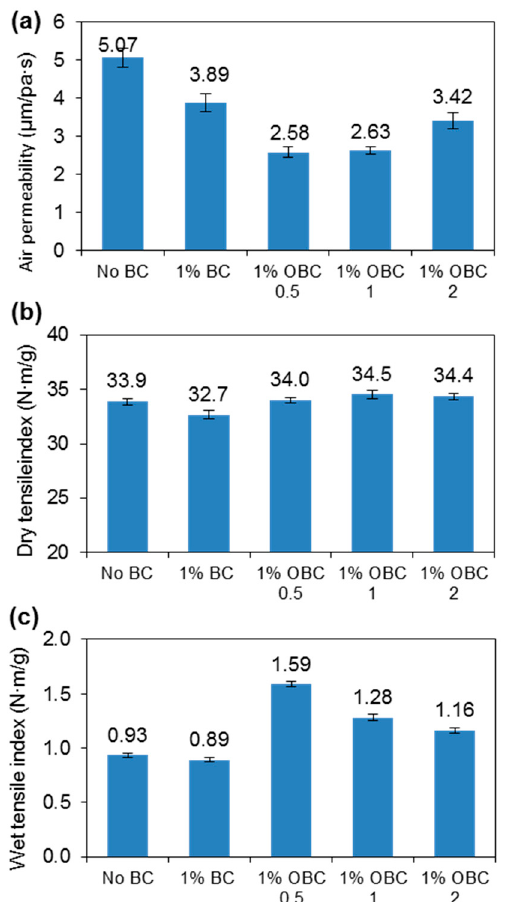
Figure 5. ( a ) Air permeability, ( b ) dry tensile index, and ( c ) wet tensile index of paper hand sheets produced from recycled fibers and oxidized BC fibers.